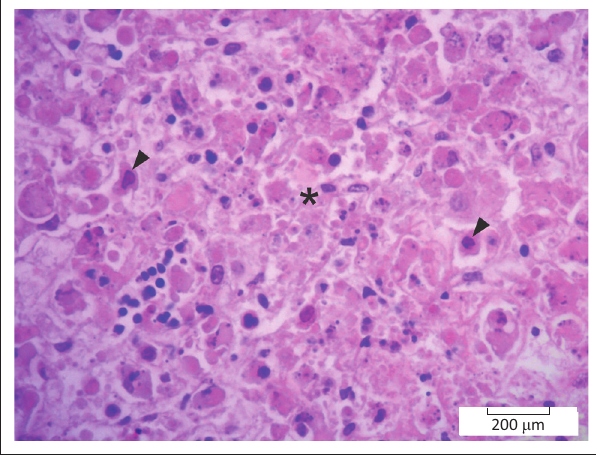
FIGURE 1: Liver, African buffalo. Area of hepatocellular necrosis ( * ) because of Phlebovirus infection (Rift Valley Fever). Several necrotic hepatocytes have intranuclear viral inclusions (arrowheads). Haematoxylin and eosin.